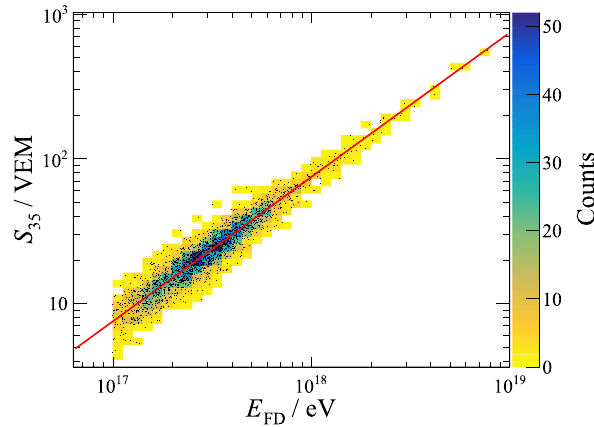
Fig. 7 Correlation between the SD shower-size estimator, S 35 , and the reconstructed FD energy, E FD , for the selected hybrid